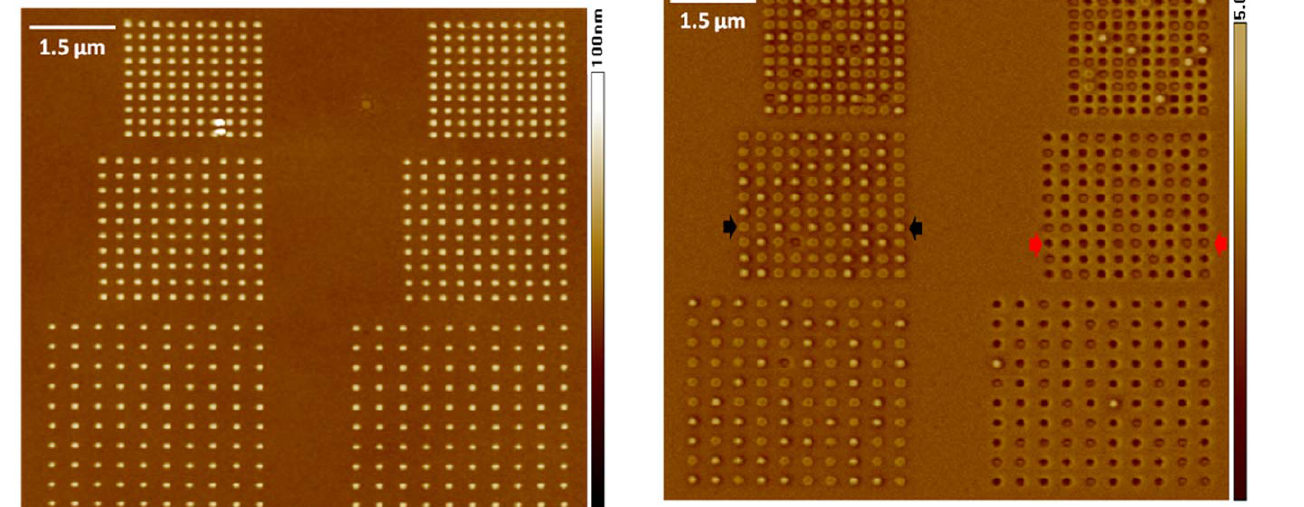
Figure 7. AFM image of the triple-stack ML-3D BPM.